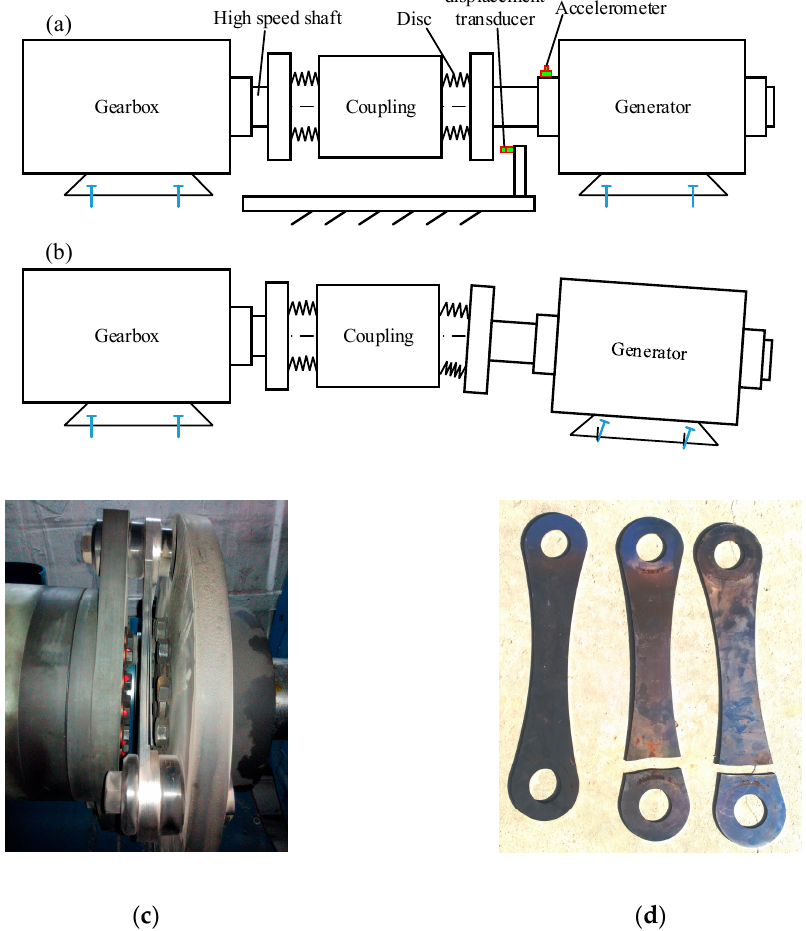
Figure 31. Disc coupling between the high-speed shaft of wind turbine gearbox and generator shaft: ( a ) disc coupling under normal state; ( b ) disc coupling under pedestal looseness; ( c ) broken discs in coupling; ( d ) disassembled discs.